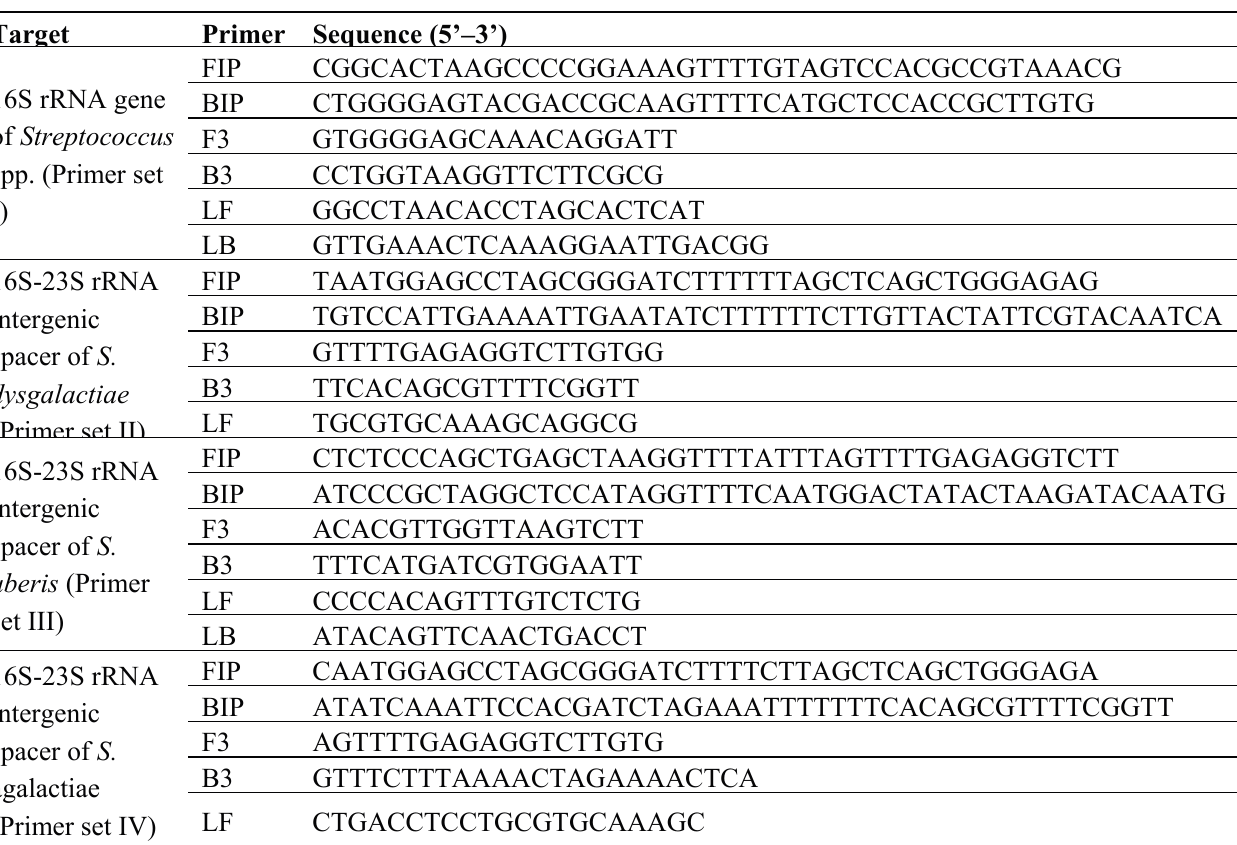
Table 2. Primers for identification and differentiation of S. dysgalactiae , S. uberis and S. agalactiae with LAMP